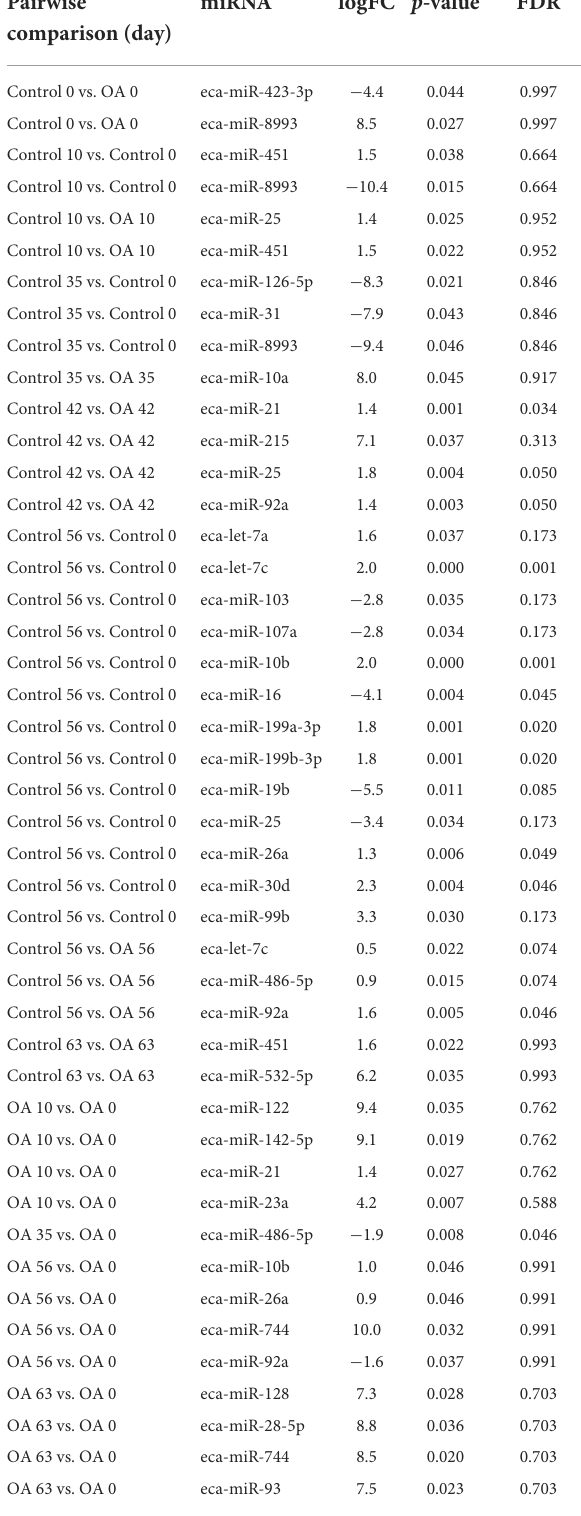
TABLE 2B Differentially expressed miRNAs following pairwise analysis in synovial fluid-derived EVs.